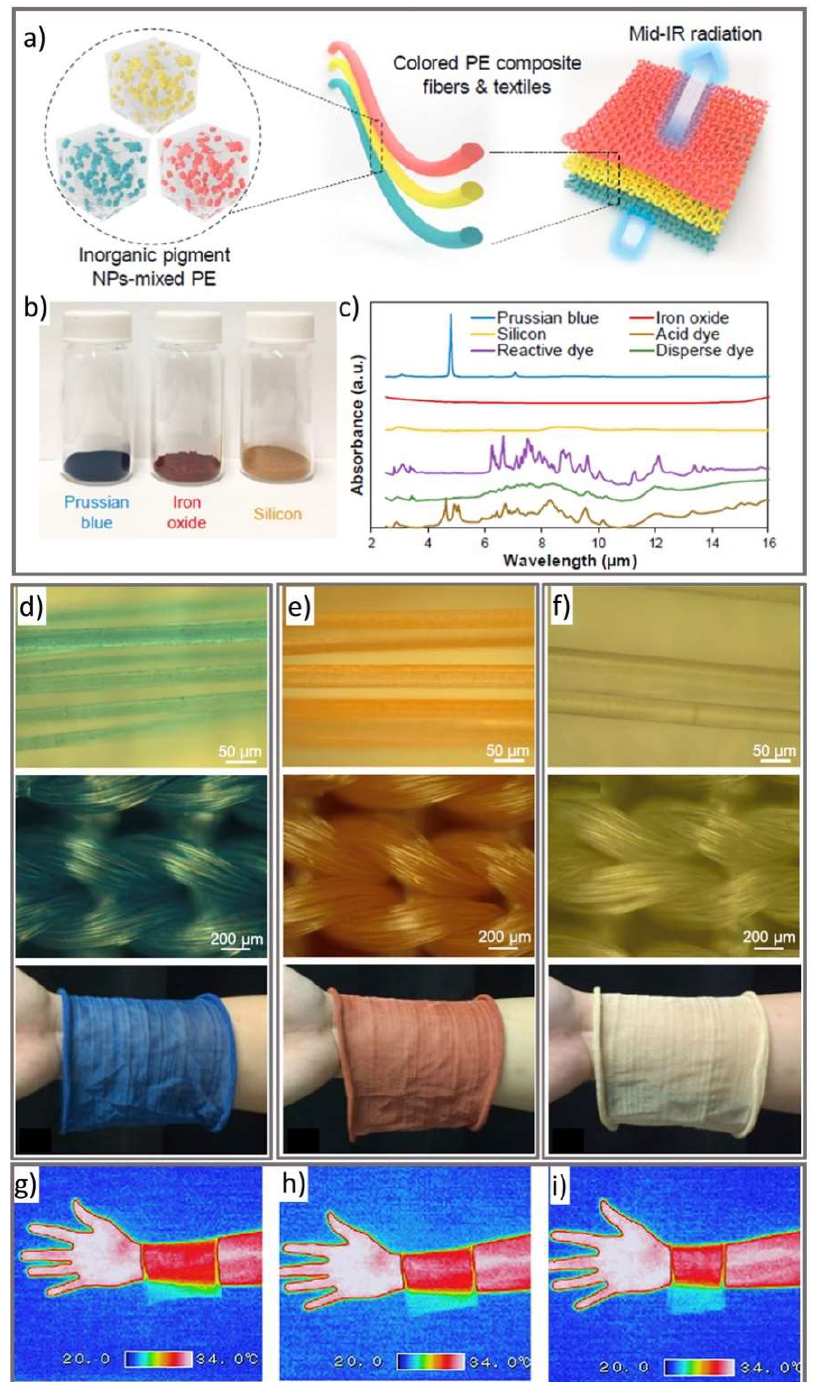
Figure 2. ( a ) Schematic illustration of mixing IR transparent nanosized pigments, Prussian blue, iron oxide (red) and silicon (yellow) with polyethylene material. The nanocomposite mixture was extruded as continuous fibers and used to make IR transparent knitted fabrics. ( b ) Optical image of the selected pigments. ( c ) The absorbance spectrum of the three pigments was analyzed using Fourier-transform infrared spectroscopy (FTIR) over the scanning range of 2–16 μm and compared with other traditional organic dyes. ( d – f ) show optical images of the extruded fibers, knitting patterns, and the final knitted textile of the three pigments. ( g – i ) show the IR images of the nanocomposite fabrics (reprinted from [31] with permission from Elsevier).